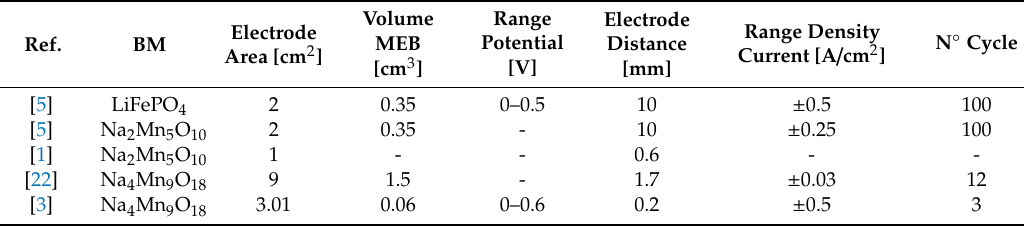
Figure 7. Schematic illustration of the crystal structure of Na 4 Mn 9 O 18 . The Mn atoms form alternated octahedron MnO 6 and tetrahedron MnO 4 to form a several channels where diffusion of Li + ions occurs (MP-1094147). Table 3. Battery materials used as cathodes in